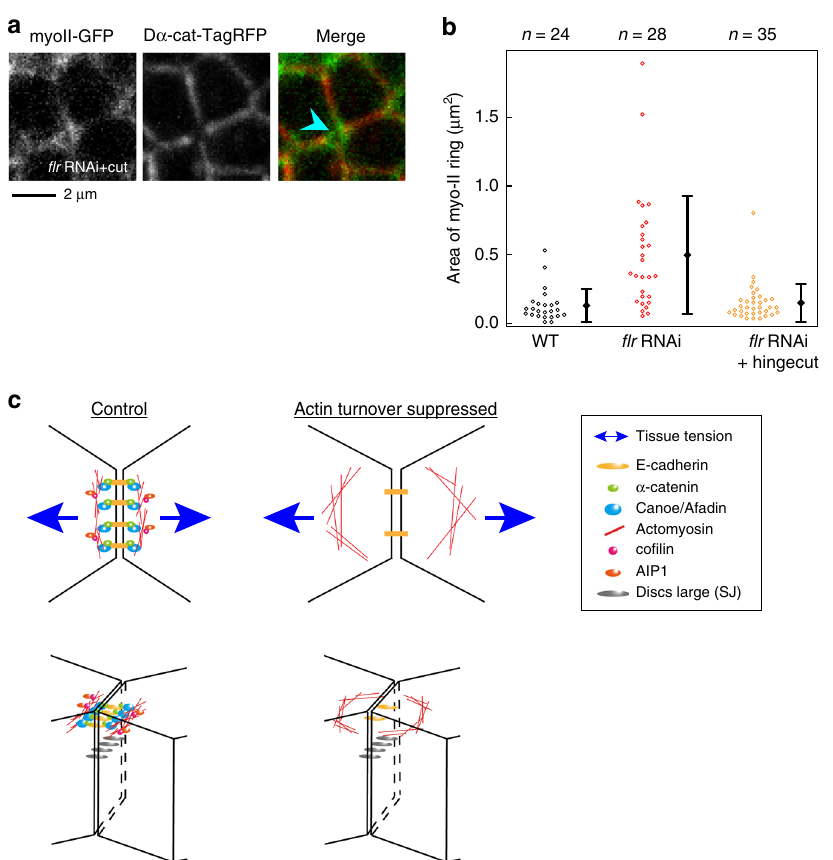
Fig. 7 myo-II ring enlargement in fl r RNAi cells is rescued by relaxing tissue stretch. a Images of myo-II-GFP (gray in a left panel, green in a right panel) and D α -cat-TagRFP (gray in a middle panel, red in a right panel) in a mechanically relaxed fl r RNAi wing. The wing was detached from the hinge at 15 h APF and observed at 24 h APF. The blue arrowhead indicates a myo-II ring on the short remodeling junction. b The myo-II ring area is plotted for each genotype (WT and fl r RNAi data were same as that shown in Fig. 6j). Steel – Dwass test: WT vs. fl r RNAi, P < 0.001, WT vs. fl r RNAi + hinge cut, P > 0.4, fl r RNAi vs. fl r RNAi + hinge cut, P < 0.001. The difference between fl r RNAi and fl r RNAi + hinge cut was statistically signi fi cant after excluding outliers above 1.2 µ m 2 . c Schematic of the defects resulting from genetic or pharmacological manipulations to stabilize F-actin. AJ (E-cad) (yellow), α -cat (green), Cno (light blue), actomyosin (red), co fi lin (magenta), AIP1 (orange), Dlg (gray), and tissue tension generated by the extrinsic stretching force (blue arrows). Top (top) and side (bottom) views are shown. Left: In WT tissue, cells maintain AJ and actomyosin integrity along the AP junction in the presence of anisotropic tissue tension. Right: F-actin stabilization weakens Cno-mediated linkage between actomyosin and AJ. Subsequently, actomyosin detaches from the AP junction. The number of ROIs examined is indicated ( b ). Data are presented as the mean ± s.d. ( b ). Scale bar: 2 µ m ( a